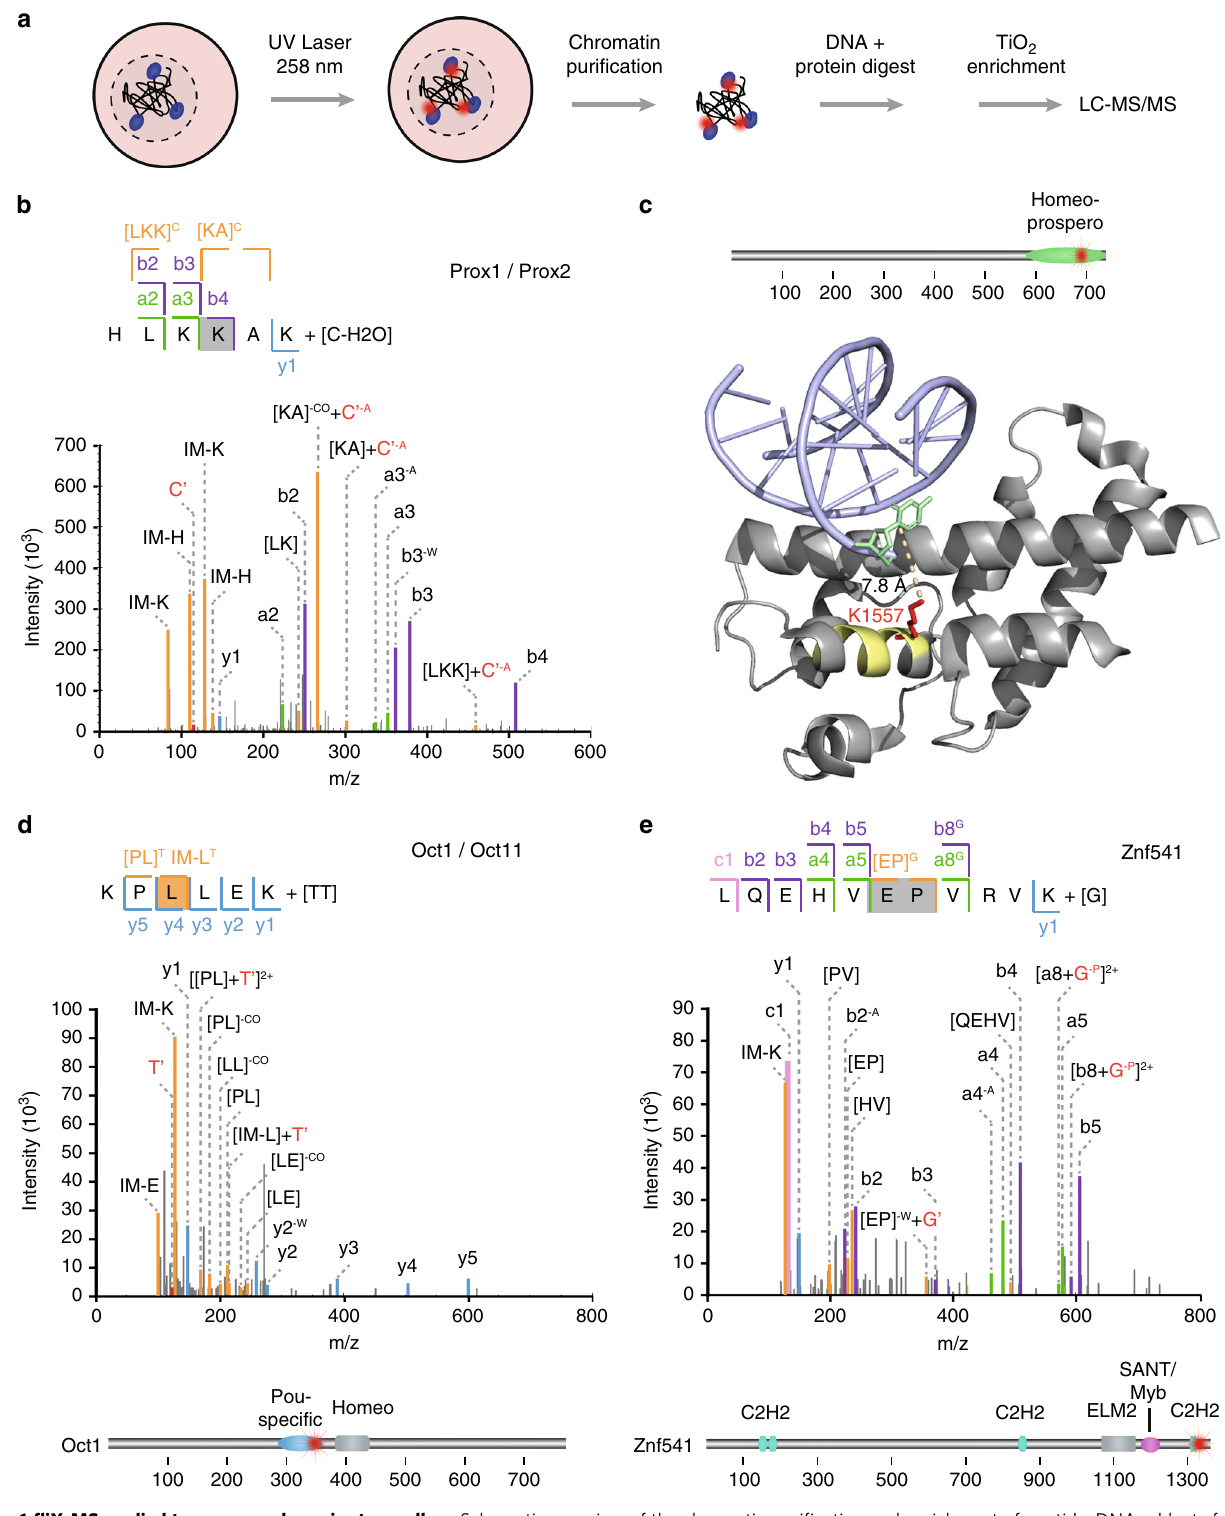
Fig. 6 fl iX-MS applied to mouse embryonic stem cells. a Schematic overview of the chromatin puri fi cation and enrichment of peptide – DNA adducts from laser UV-cross-linked embryonic stem cells. b MS2 ion series and spectra of the transcription factor Prox1/2 peptide 584 HLKKAK 589 cross-linked to a deoxycytidine monophosphate. Abbreviations as in Fig. 4. c Crystal structure of the D. melanogaster prospero domain (PDB ID: 1XPX 64 ) and location of the 1552 HLRKAK 1557 peptide, which is homologous to the cross-linked 584 HLKKAK 589 peptide. The peptide 1552 HLRKAK 1557 is highlighted in yellow, deoxycytidine in green, and K1557 in red. The distance of K1557 to the cytosine is indicated. d , e MS2 ion series of two other high-con fi dence cross-links of the transcription factor Oct1/Oct11 and the zinc fi nger protein Znf541. Abbreviations as in Fig. 4. Schematic representation of the cross-link location and domain structure is shown below the respective MS2